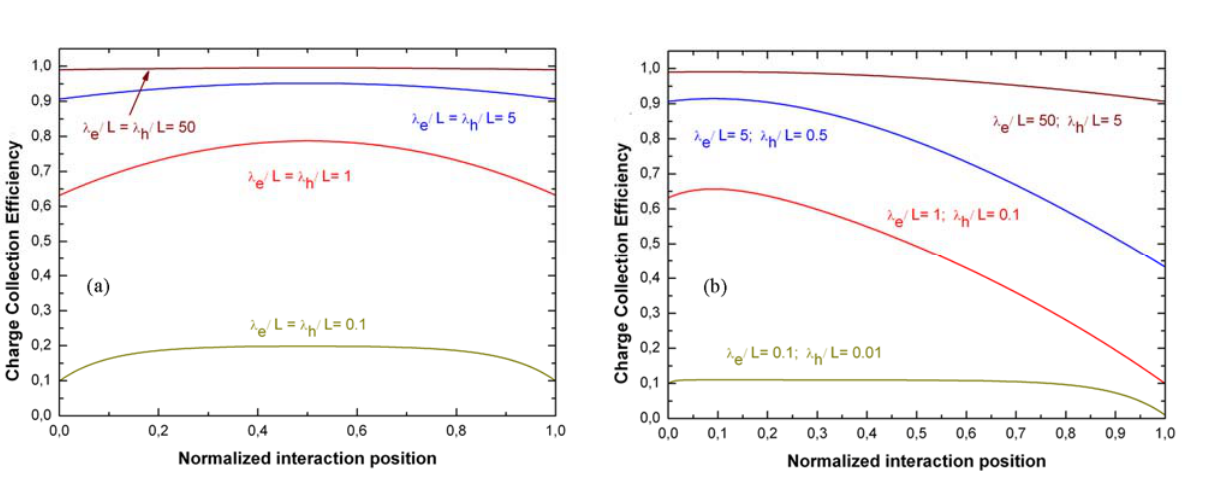
Figure 3. Charge collection efficiency (CCE) vs. the normalized interaction position of incoming photons. The CCE curves are calculated for different values of the λ /L ratios; (a) identical λ /L ratios for both electrons and holes; (b) the electron λ /L ratio is always 10 times greater than that of the